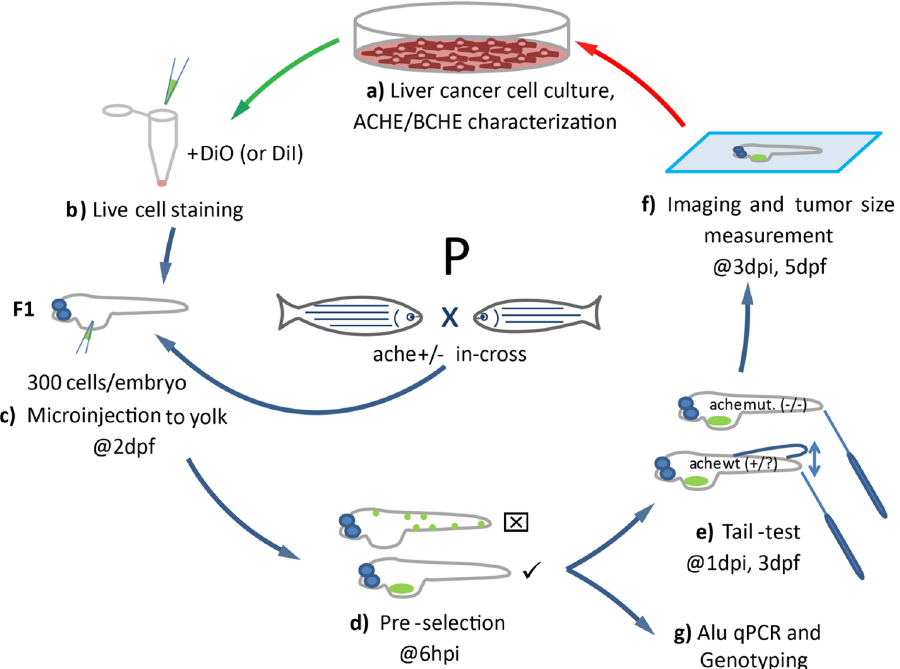
Figure 1. Schematic representation of the development of the liver cancer xenograft model in zebrafish ache mutants. ( a ) Liver cancer cells are grown in culture and characterized for ACHE / BCHE expression and activity. ( b ) Selected cell lines are harvested and stained with live dye DiO (or DiI for ALU quantification). ( c ) Embryos from ache heterozygous in-cross are injected with 300 cells into their yolk sac at 2 dpf. ( d ) At 6 hpi, embryos with positive signal are selected and embryos with signal from outside the injection site are not used. ( e ) After blind injection, mutant larvae are separated from + /? by a touch-evoked tail response test (tail-test). ( f ) All larvae are fixed and mounted before tumor size is measured and compared between mutant and wild-type larvae. ( g ) Alternatively, larvae fixed for ALU based xenograft quantification